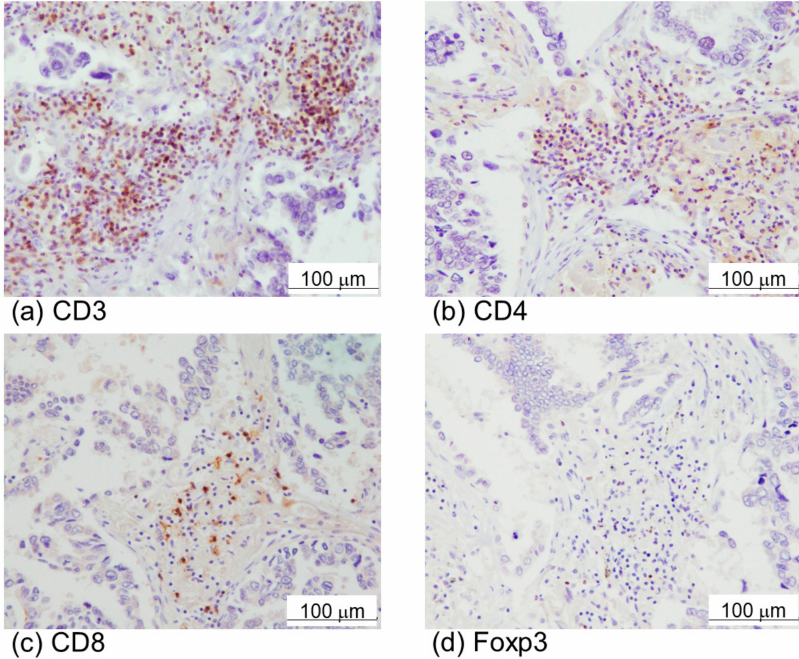
Figure 2. Immunohistochemistry of immune cell markers, CD3 ( a ), CD4 ( b ), CD8 ( c ), and Foxp3 ( d ) in lung